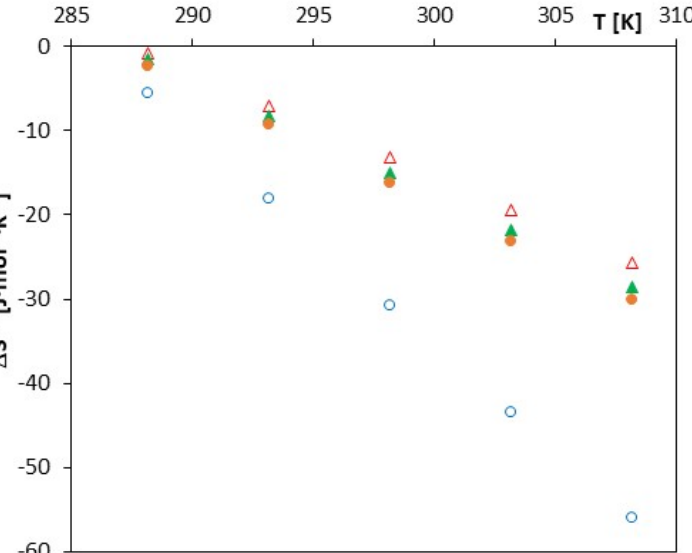
Figure 6. The plots of the dependence of 𝛥𝑆 (cid:3042) (J ∙ mol − 1 ∙ K − 1 ) in the function T (K) for α -cyclodextrin with all studied salts: ∆ - trans -cinnamic acid; ▲ - trans-p -coumaric acid; ● - trans -caffeic acid; and ○ - trans -ferulic acid.